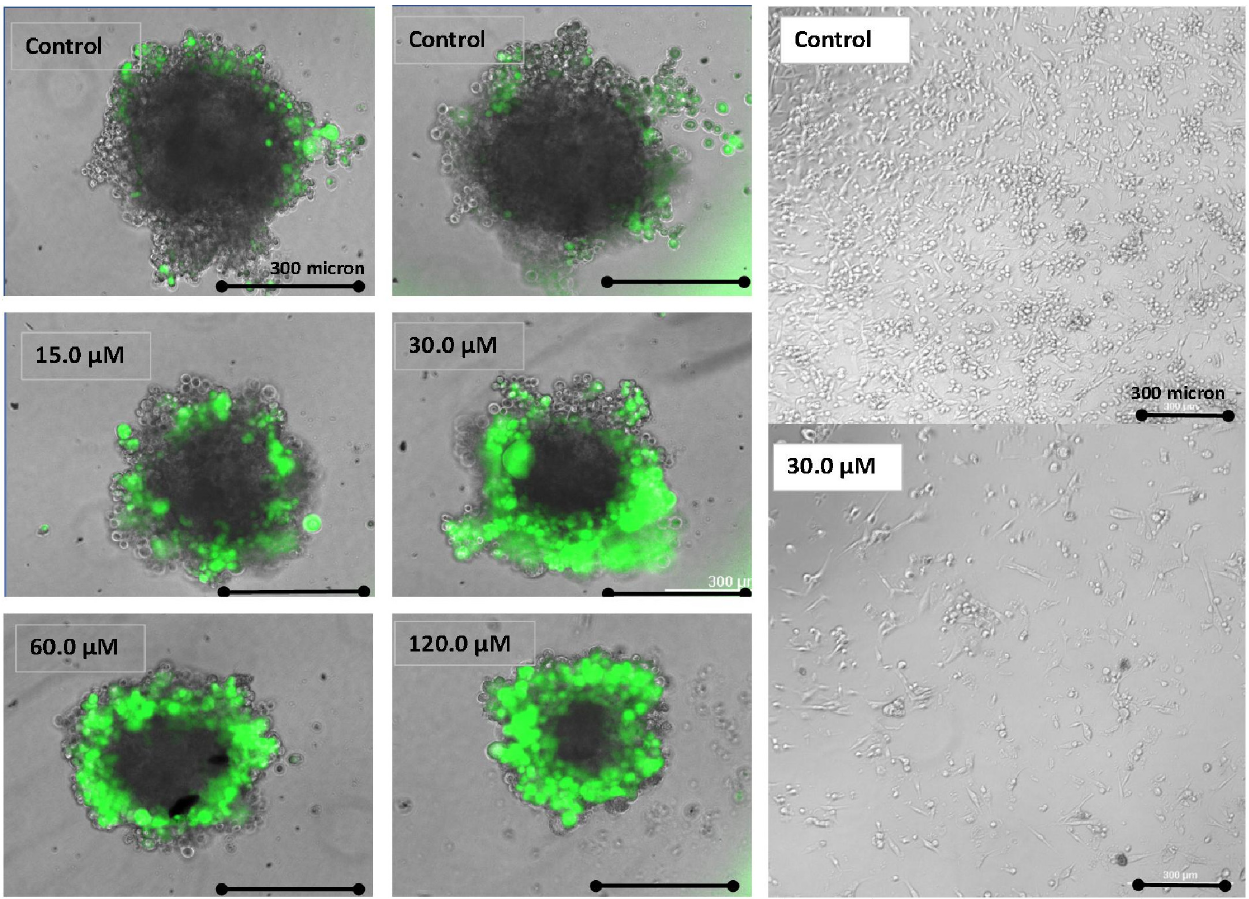
Figure 6. Cytostatic effects of GNE-140 in MDA-MB-231 3D cells spheroids, after 2 weeks of incubation (left-hand panel). Live spheroid imaging was obtained using fluorescein diacetate (FDA) merged with phase contrast images. The right-hand panel confirms 2D monolayer morphology in live static cells when treated with GNE-140 (30 µ M) after 7 day proliferation. These findings confirm that the loss of LDH does not impact energy, but rather the mitotic division of cells, selec- tively.